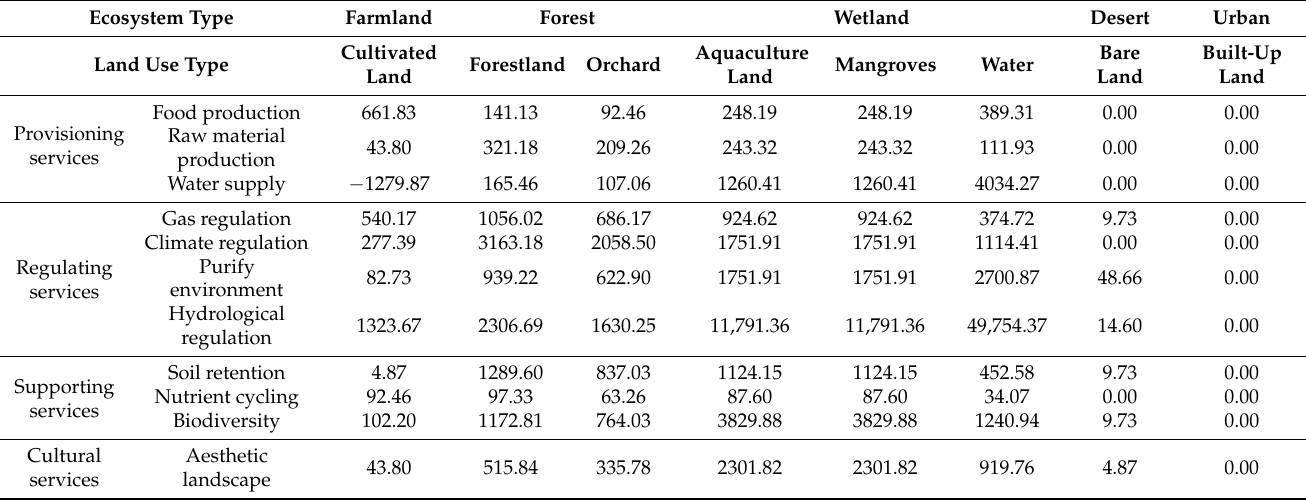
Table 4. Ecosystem service equivalent value per unit area